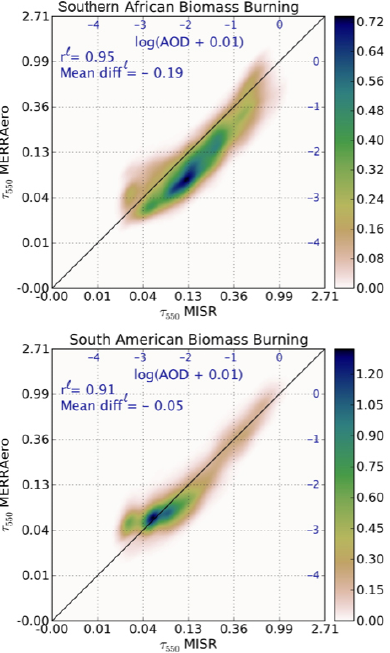
Figure 9. Comparison of 550nm MERRAero AOD to MISR re- trievals over the southern African (top) and South American (bot- tom) biomass burning regions for the period JJA